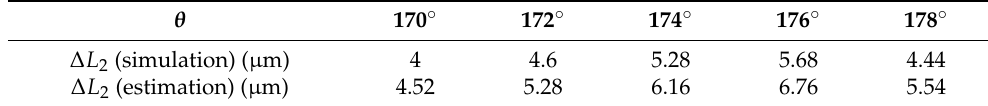
Table 1. Extension simulation and estimation comparison.